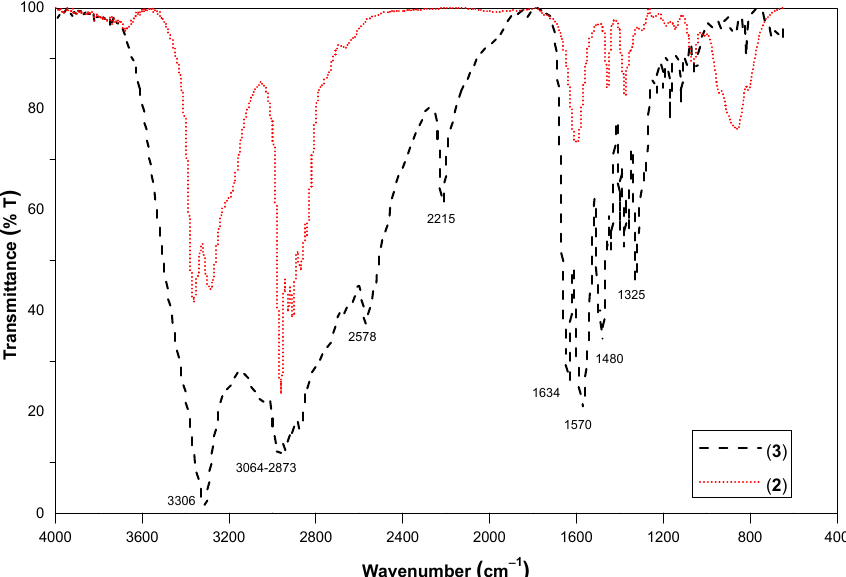
Figure 4. FTIR (ATR) spectra of (2) (red short dot line) and aminolysed product (3, black dash line) obtained by method C.